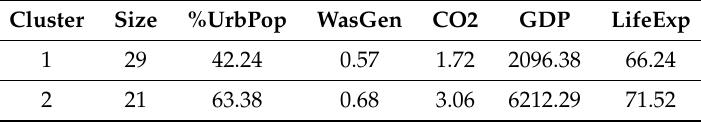
Table 4. Mean values of quantitative variables for each cluster.